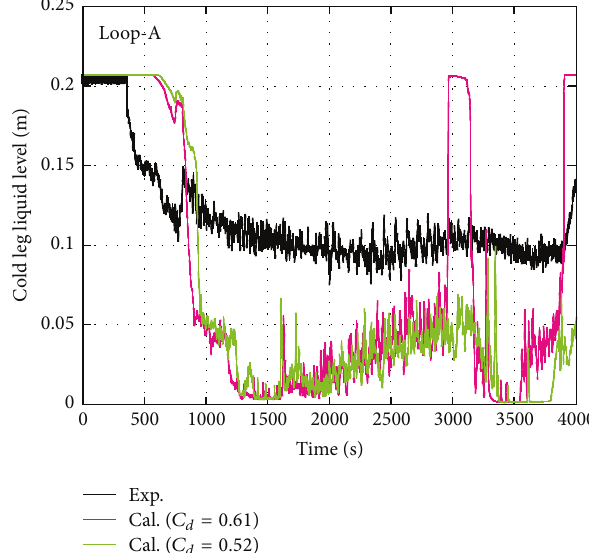
Figure 7: LSTF and RELAP5 results for cold leg liquid level in loop- A in case of release of dissolved gas.